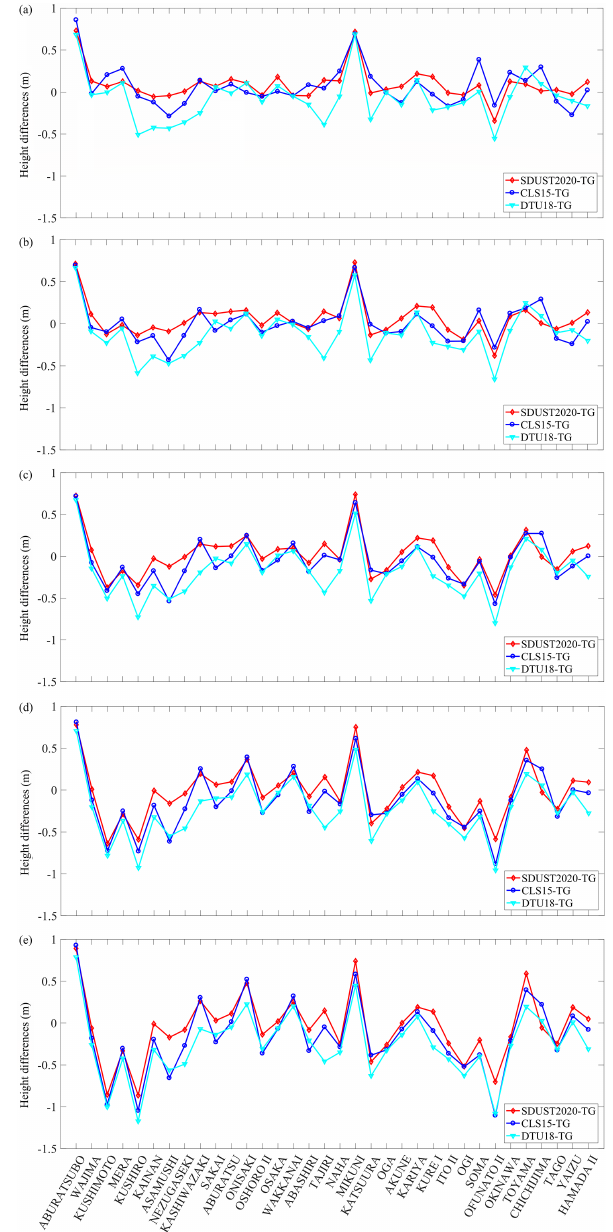
Figure 12. Sea surface height differences of different models com- pared with 34 GPS-leveled tide gauges around Japan in different search radii. Panels (a) , (b) , (c) , (d) , and (e) correspond to the search radius of 10, 20, 30, 40, and 50km,